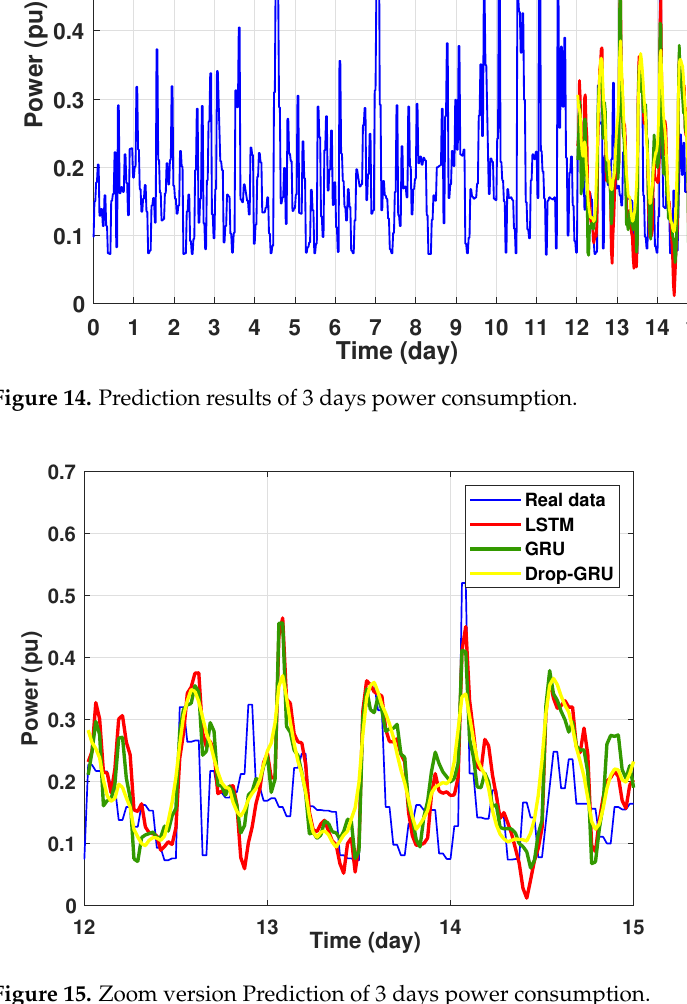
Figure 15. Zoom version Prediction of 3 days power